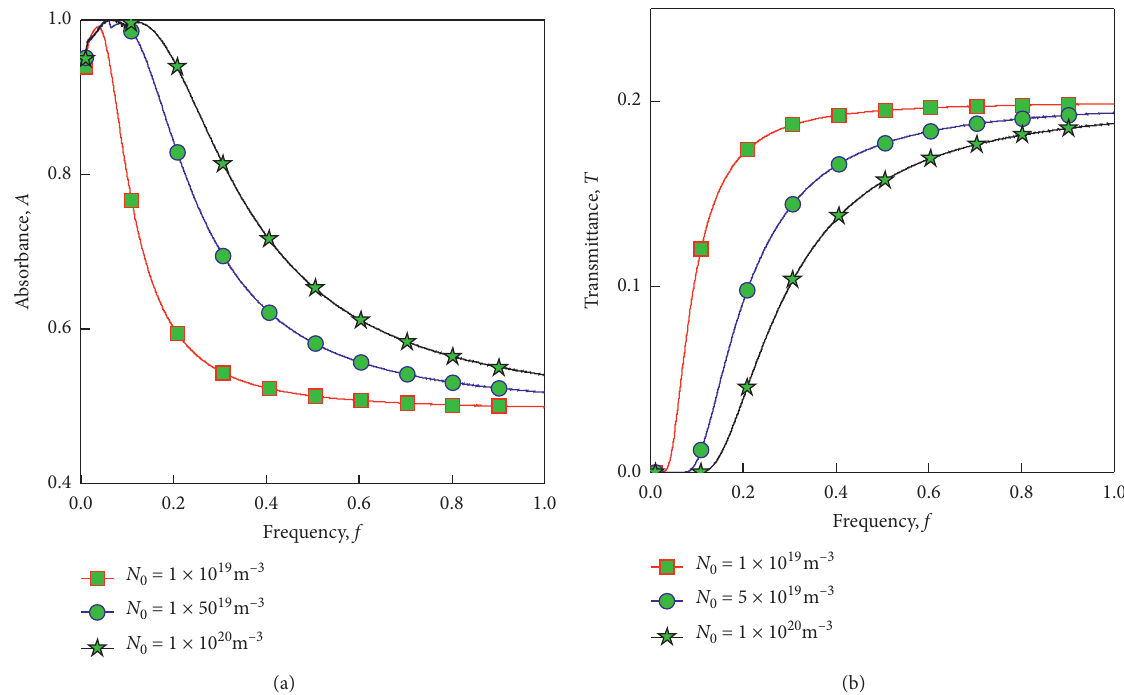
Figure 4: Absorbance and transmittance versus wave frequency for different maxima in the electron density in a dusty plasma environment.